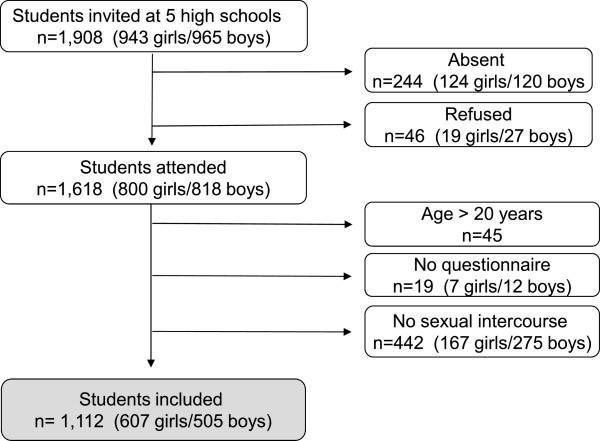
Study population.